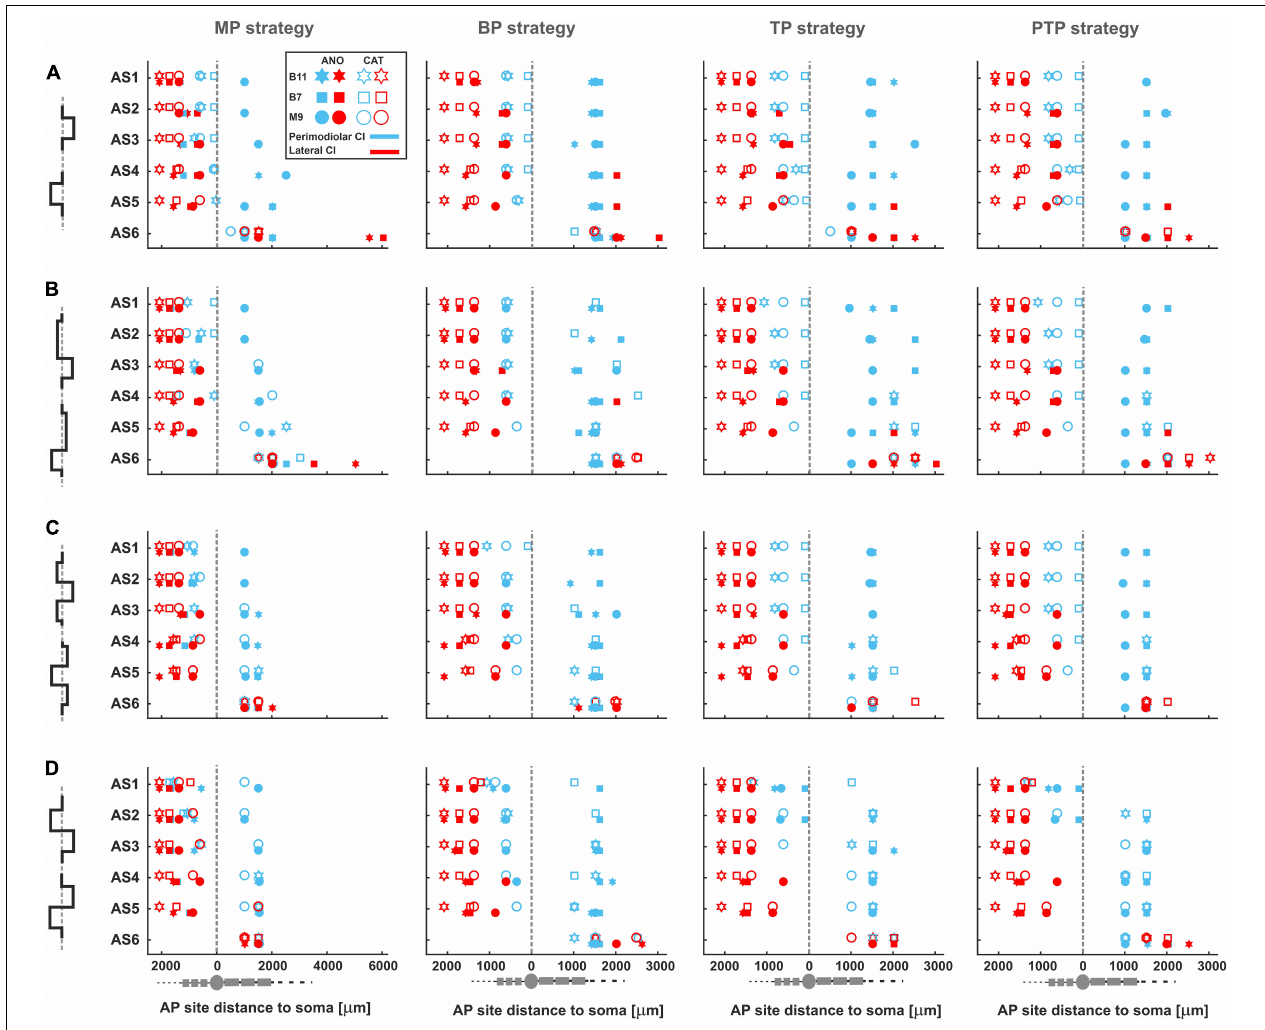
FIGURE 11 | AP initiation sites at ANO and CAT thresholds for four pulse shapes in four stimulation strategies. The TNs, B11, B7, and M9, are demonstrated with star, rectangle, and circle, respectively. In addition, the lateral and perimodiolar CI systems are indicated with red and blue colors. Pulse polarity is identified by filled (ANO) and unfilled shapes (CAT). Gray dashed lines show the soma positions. AP initiation sites for (A) monophasic, (B) pseudomonophasic, (C) triphasic, and (D) biphasic pulse. Legend from top-left panel A applies to all panels.